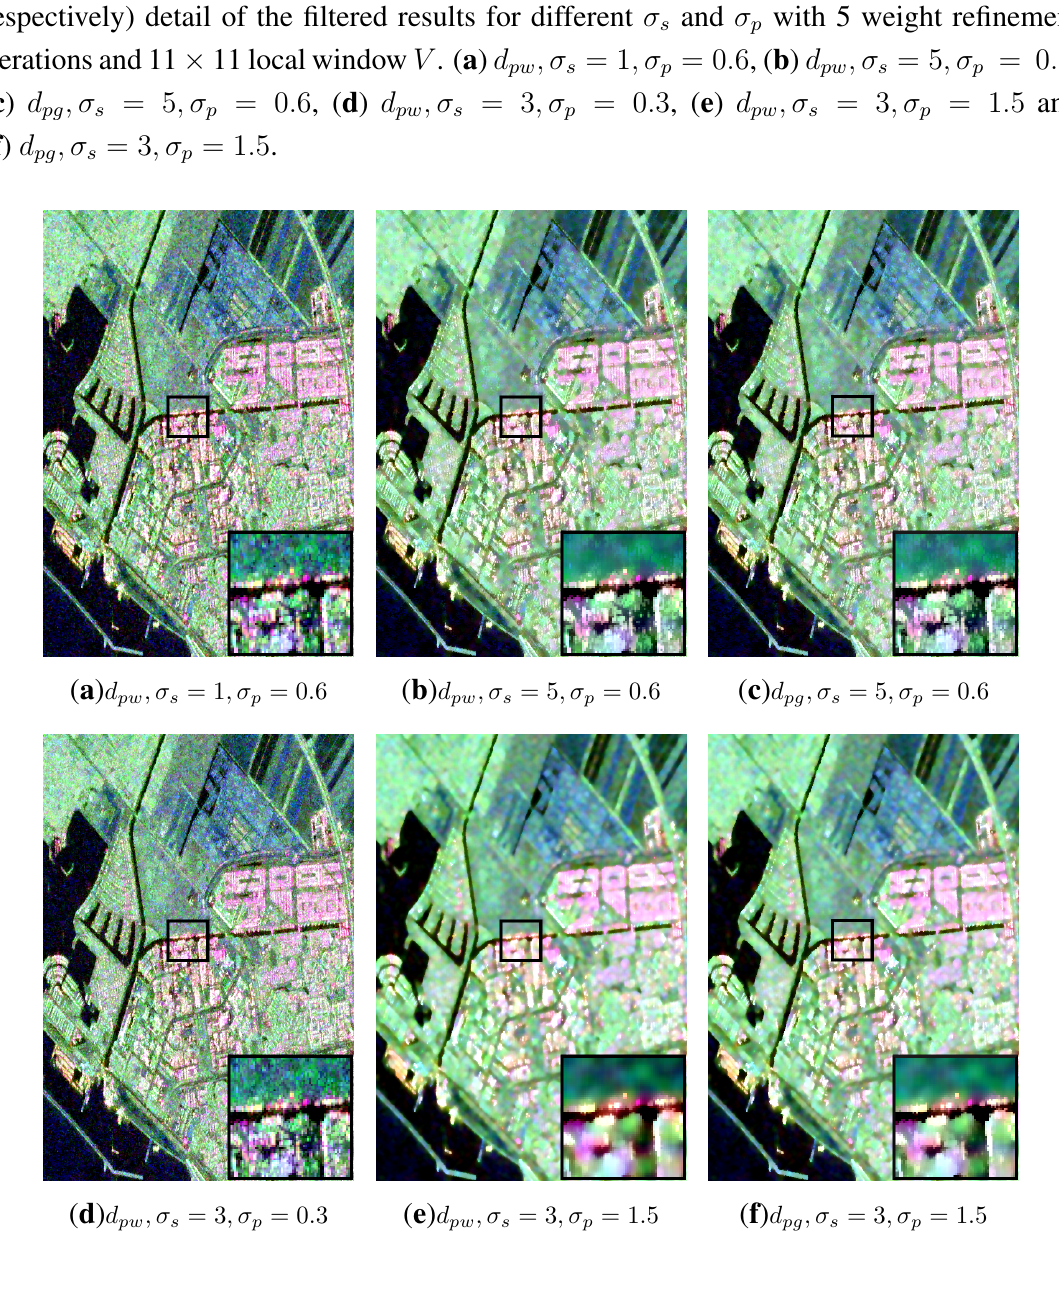
Figure 8. Pauli RGB ( | HH − V V | , | HV + V H | , | HH + V V | are assigned to RGB channels, respectively) detail of the filtered results for different σ iterations and 11 × 11 local window V . ( a ) d